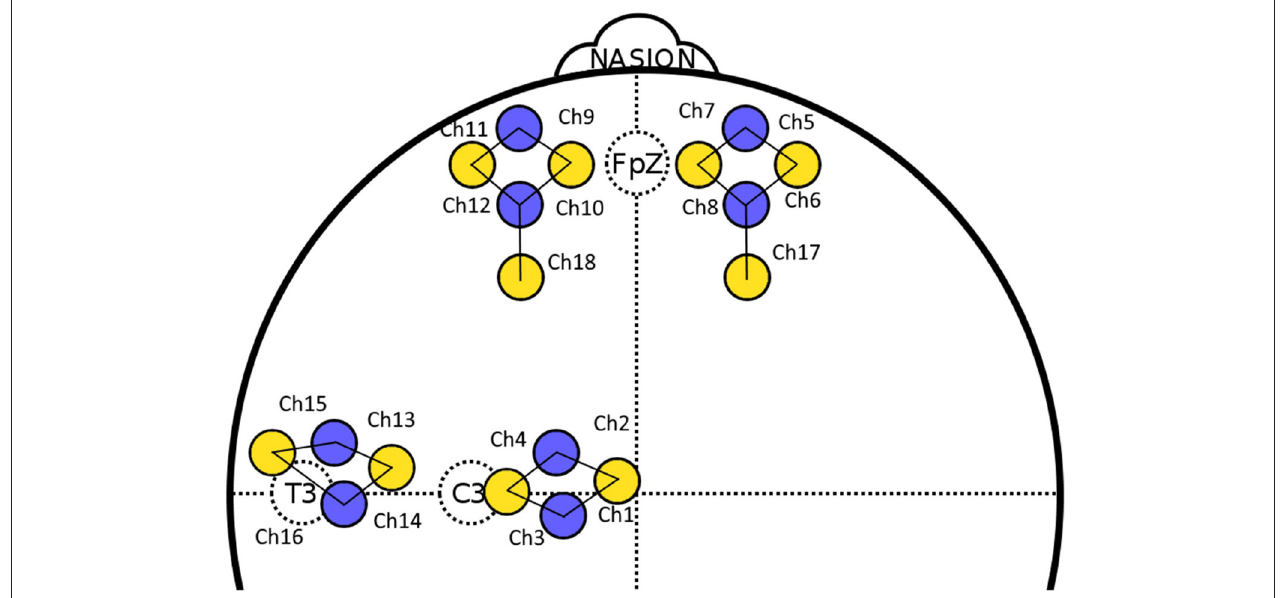
FIGURE 1 | The layout of all fNIRS channels on the scalp. The yellow circles represent transmitter optodes and the blue circles represent receiver optodes. A channel is lying between each transmitter-receiver pair. Channels 1–4 correspond to the motor cortex, channels 5–8 correspond to the right PFC, channels 9–12 correspond to the left PFC, and channels 13–16 correspond to the left temporal cortex. Channels 17 and 18 correspond to the right and left DLPFC, respectively. Certain electroencephalogram’s electrode positions, in accordance with 10–20 international system, are included for references.